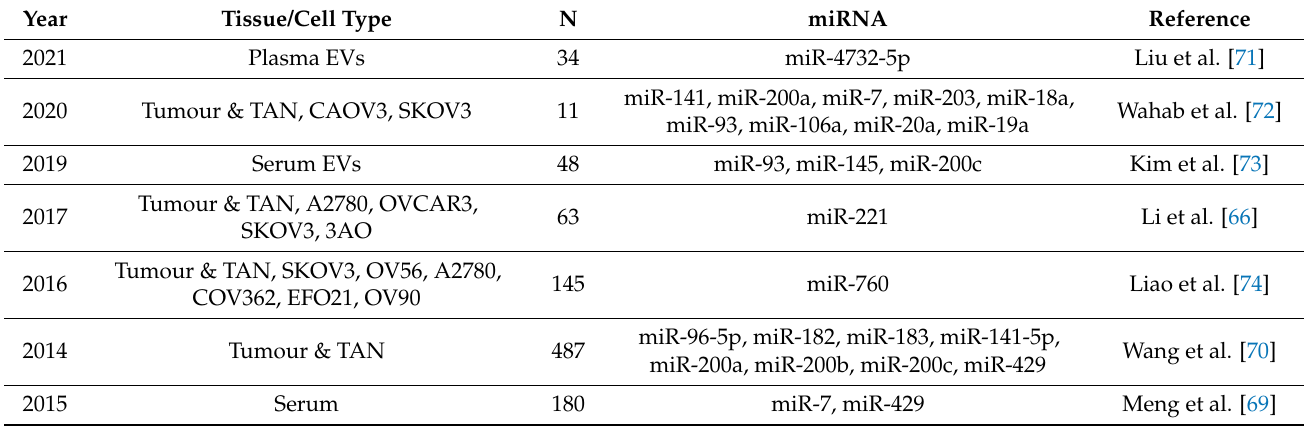
Table 3. MiRNAs upregulated in ovarian